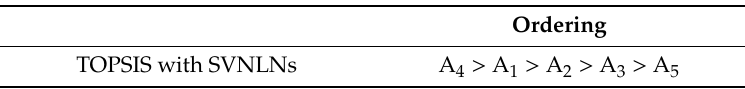
Table 7. Ordering of the green